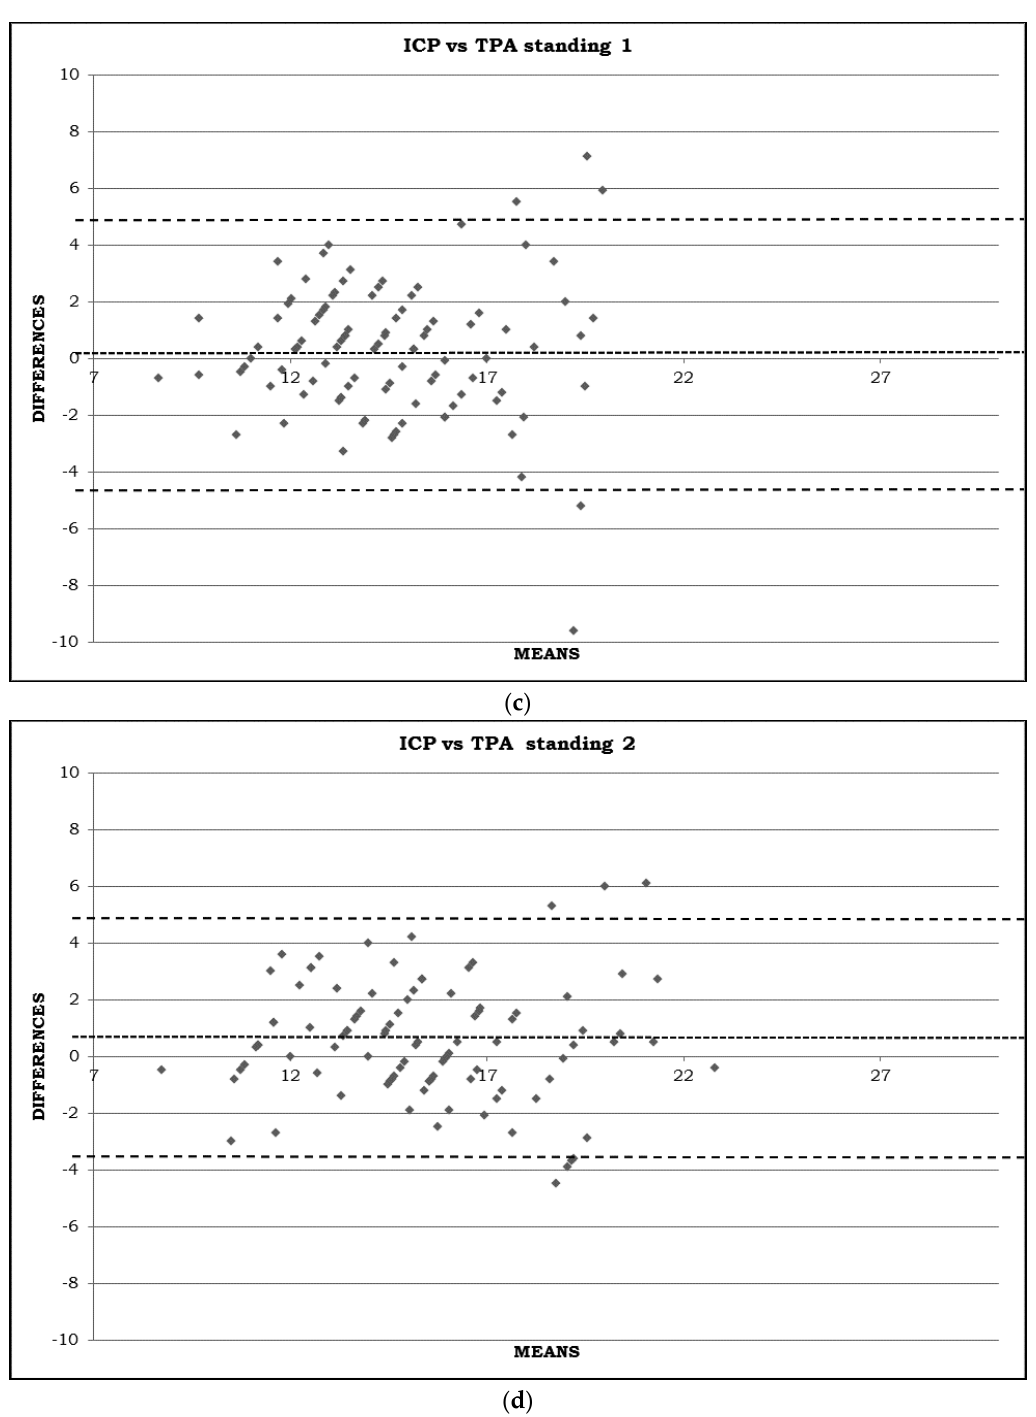
Figure 1. ( a ) IOP measured in sitting position using Icare PRO (ICP) and Tono-Pen AVIA (TPA) (mmHg). Bland–Altman diagram with mean difference and agreement limits (including 95% of all difference values). ( b ) IOP measured in supine position using Icare PRO (ICP) and Tono-Pen AVIA (TPA) (mmHg). Bland–Altman diagram with mean difference and agreement limits (including 95% of all difference values). ( c ) IOP measured in standing 1 position using Icare PRO (ICP) and Tono-Pen AVIA (TPA) (mmHg). Bland–Altman diagram with mean difference and agreement limits (including 95% of all difference values). ( d ) IOP measured in standing 2 position using Icare PRO (ICP) and Tono-Pen AVIA (TPA) (mmHg). Bland–Altman diagram with mean difference and agreement limits (including 95% of all difference values).